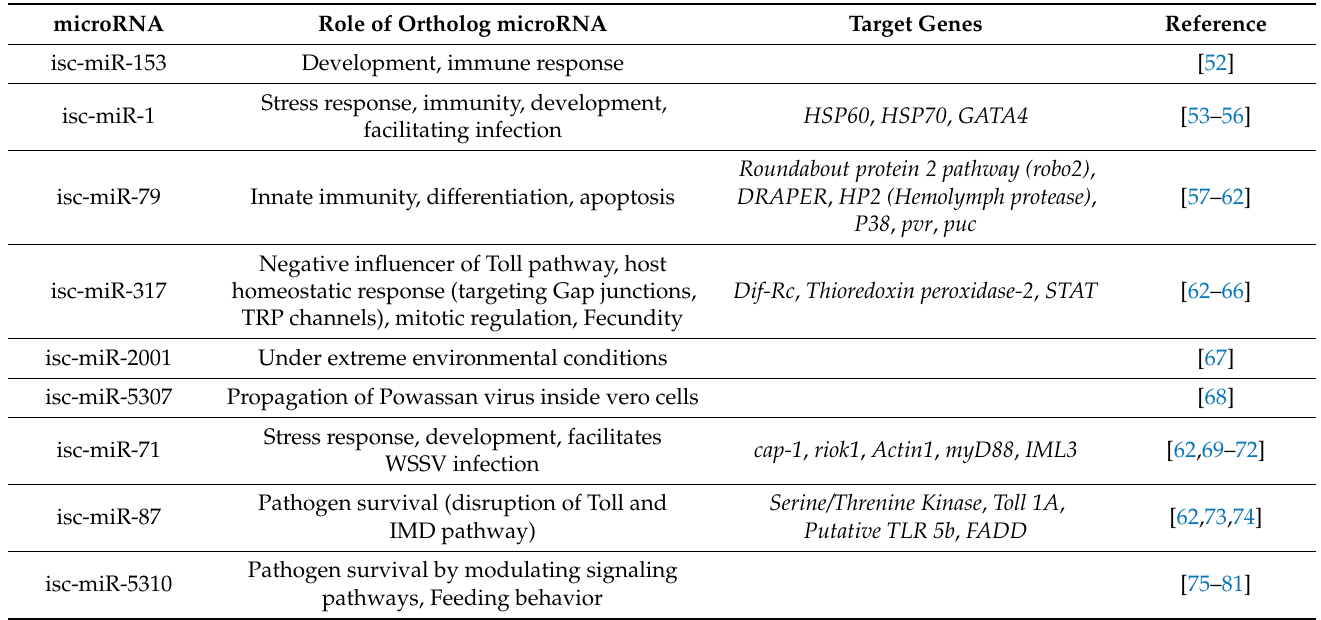
Table 2. List of differentially expressed microRNAs detected in Borrelia-burgdorferi -infected tick salivary glands and their putative